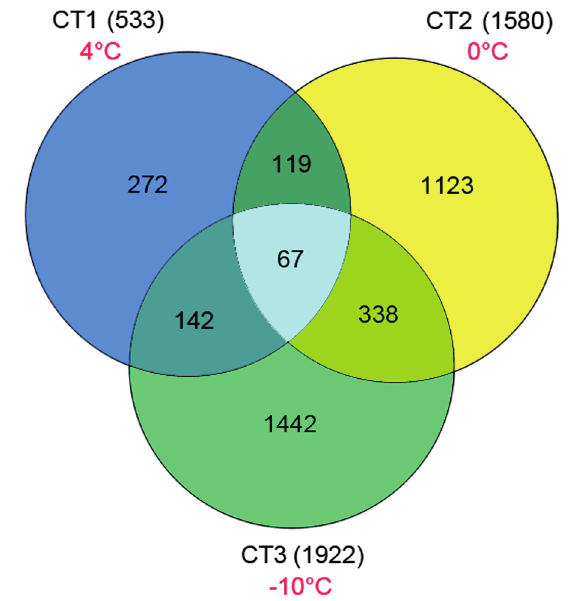
Figure 7. Differentially expressed genes in P. subulata under low temperatures. The numbers of up-regulated and down-regulated genes in cold-treated (CT) samples are shown. We used “false discovery rate ≤ 0.001 and the absolute value of log 2 Ratio ≥ 1” as the threshold to judge the significance of differences in gene expression. Control (CK) plants were grown at 20 °C. CT1, CT2 and CT3 plants were incubated at 4, 0 and − 10 °C, respectively.